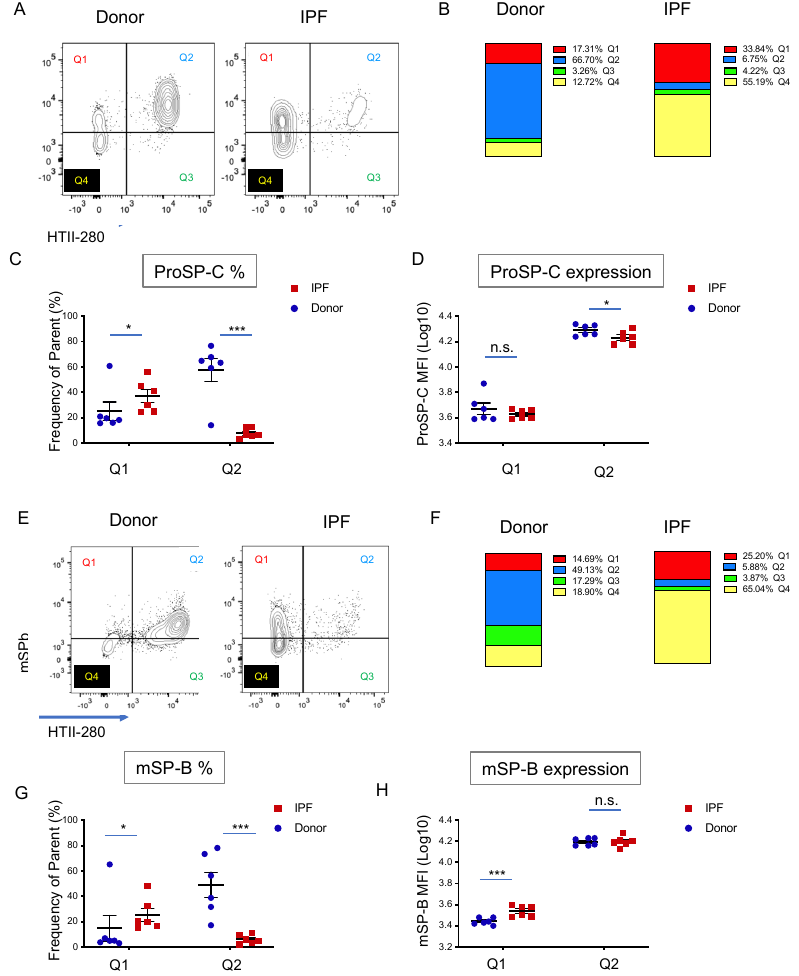
Figure 3. Surfactant protein expression in the epithelial compartment of donor and IPF lung. ( A ) Representative flow cytometry panels of proSP-C and HTII-280 expression in the epithelial compartment (DAPI − CD45 − CD31 − EpCAM + ) of donor ( n = 6) and IPF ( n = 6) lung preparations. ( B ) Average contribution of the Q1–Q4 populations to the epithelial compartment of the samples shown in ( A ), showing the change in epithelial composition in IPF lung compared to donors. Left column: donors; right column: IPF. ( C ) Quantification of the population frequency of Q1 and Q2 in donor (blue dot) and IPF (red square) lung samples shown in ( A ). ( D ) Quantification of the MFI as a measure of proSP-C expression level (log10 MFI) in the Q1 and Q2 populations of the samples shown in ( A ). ( E ) Representative flow cytometry panels of mSP-B and HTII-280 expression in the epithelial compartment (DAPI − CD45 − CD31 − EpCAM + ) of donor ( n = 6) and IPF ( n = 6) lung preparations. ( F ) Average contribution of the Q1–Q4 populations to the epithelial compartment of the samples shown in ( E ). Left column: donors; right column: IPF. ( G ) Quantification of the population frequency of Q1 and Q2 in donor and IPF lung samples in ( E ). ( H ) Quantification of the MFI as a measure of mSP- B expression level in the Q2 population of the samples in ( E ). Data are presented as the means ± SEM of the log10 (MFI) values. * p < 0.05, *** p < 0.001, ns = not significant by Student t